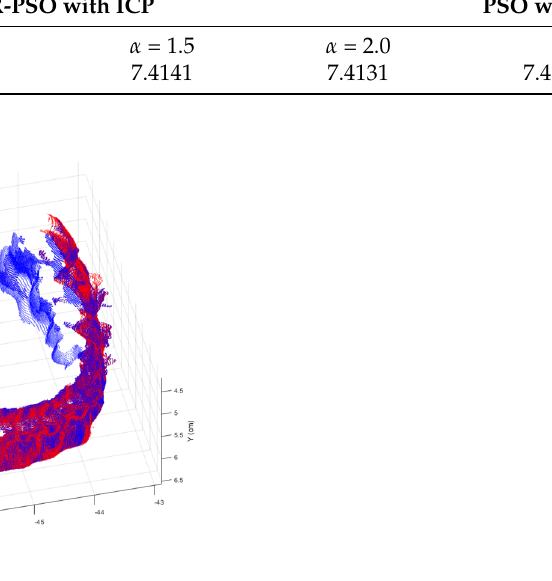
Figure 14. The final registration result of six consecutive views of the orthodontic-tooth model from the SR-PSO with the ICP.